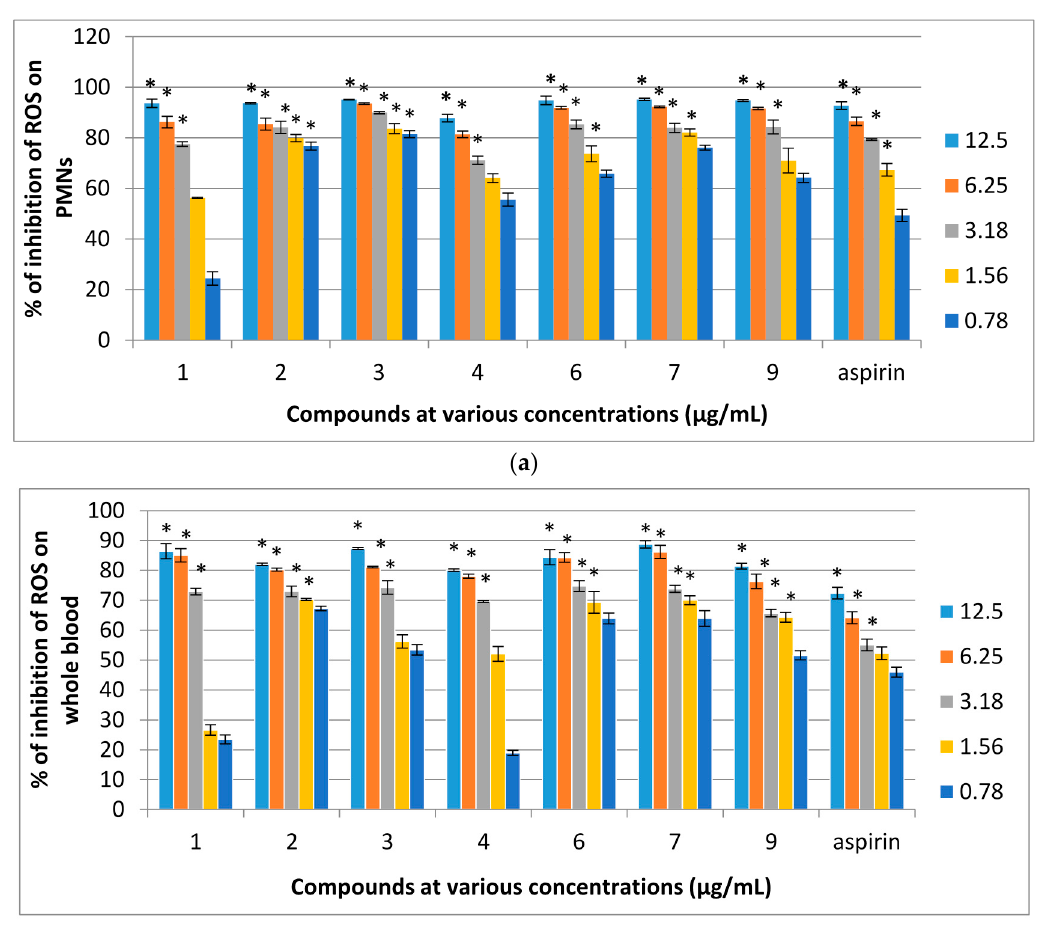
Figure 4. ( a ) Dose dependent percentage of inhibition of ROS inhibitory activity of compounds isolated from F. aurantiaca on PMNs and ( b ) whole blood assayed by luminol amplified chemiluminescence. Data are mean ± SEM ( n = 3).* p < 0.05 is significant difference compared with the respective control determined by one-way ANOVA followed by Tukey’s test.